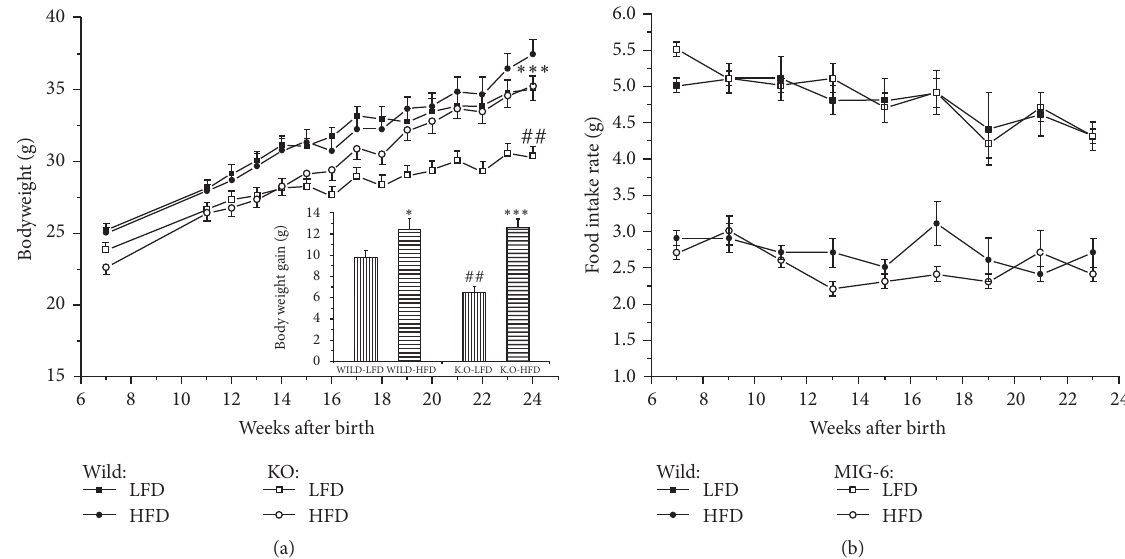
Figure 1: Bodyweight changes and effect of high-fat diet in Mig-6 f/f and Mig-6 d/d mice. (a) Bodyweight changes of Mig-6 f/f and Mig-6 d/d mice from 7 to 23 weeks of age. (b) Average food intake rate. ∗ and ∗∗∗ indicate 𝑃 < 0.05 and 𝑃 < 0.001 , versus LFD treated group in the same genotype, respectively. ## indicate 𝑃 < 0.01 , versus Mig-6 f/f . Data are presented as mean ± SE from 9 to 10 mice per group.